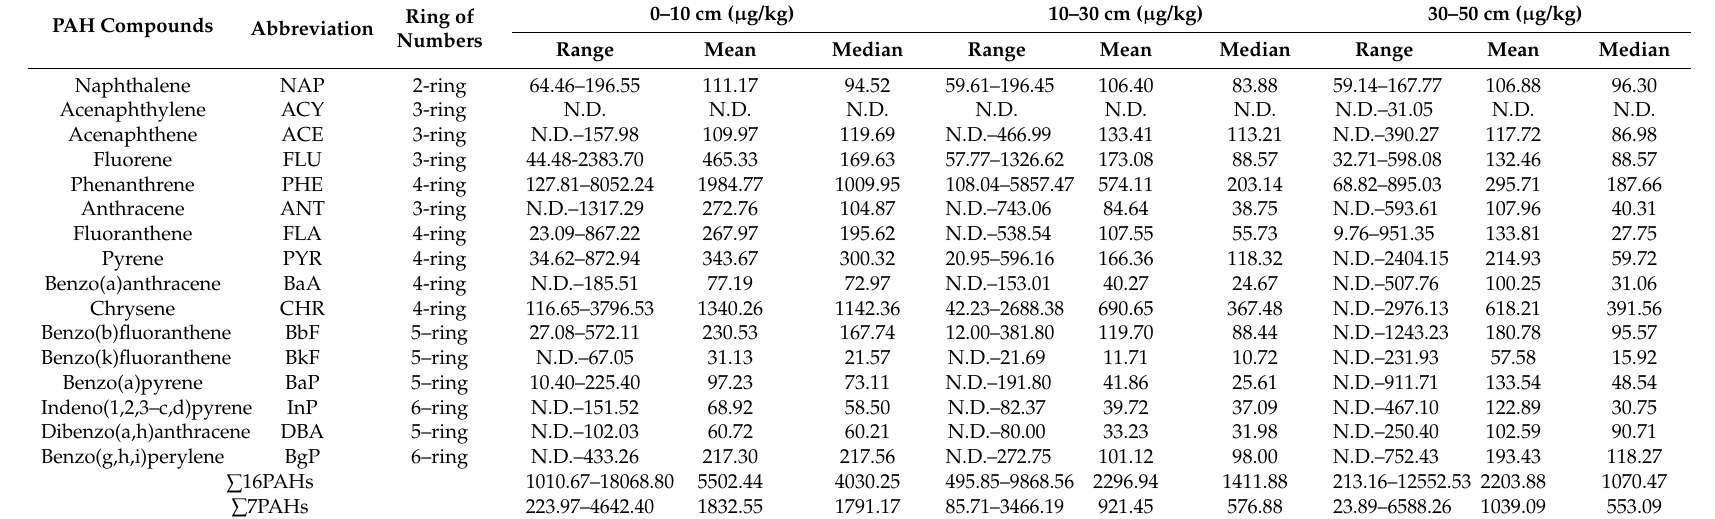
Table 2. Concentrations of individual PAHs, ∑ 16PAHs and ∑ 7PAHs in the samples from different layers of